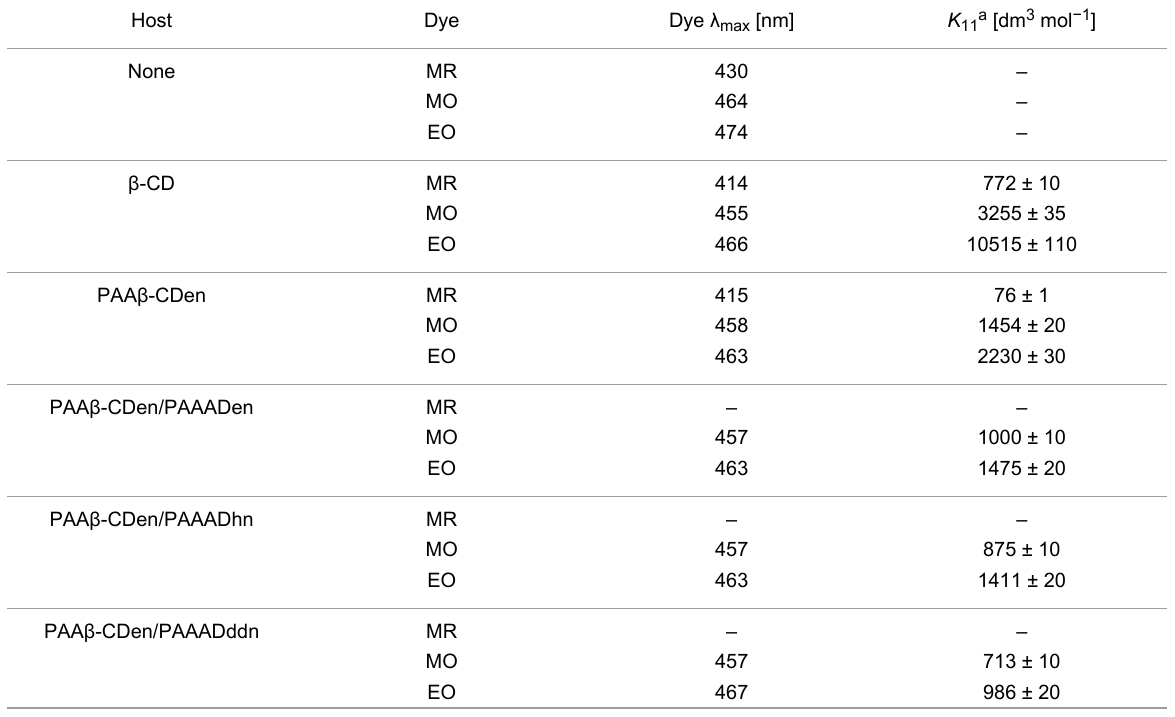
Table 2: Dye UV–vis absorption λ max and complexation constants, K 11 , for complexation of MR, MO and EO by β -CD, β -CDen substituents of PAA β - CDen and β -CDen substituents of PAA β -CDen substituted poly(acrylate) in binary mixtures with PAAADen, PAAADhn or